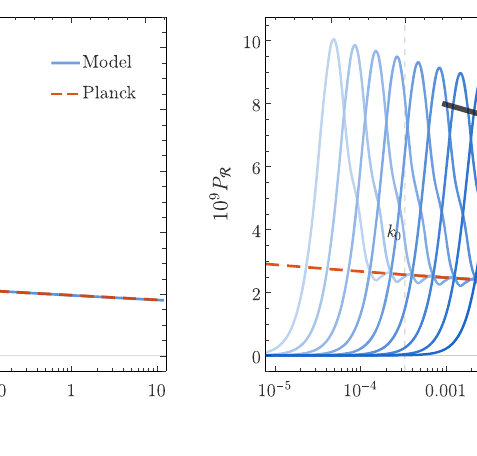
validatingtheupperlimitof k = 10 2 k c chosenforsettingtheinitialcon- dition before the onset of inflation. (Right Panel) The range of modes affected by the pre-inflationary effects is blue shifted as the value of the parameter ˜ K increases. In order for any imprints on the power spectrum to be visible while at the same satisfying the observational constraints, the relation (4.8) needs to be